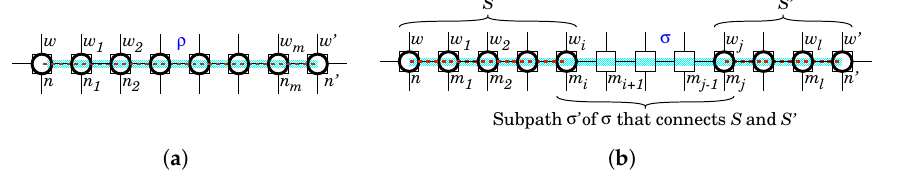
Figure 5. Illustration of Property 1. ( a ) “If” part; ( b ) “Only if”